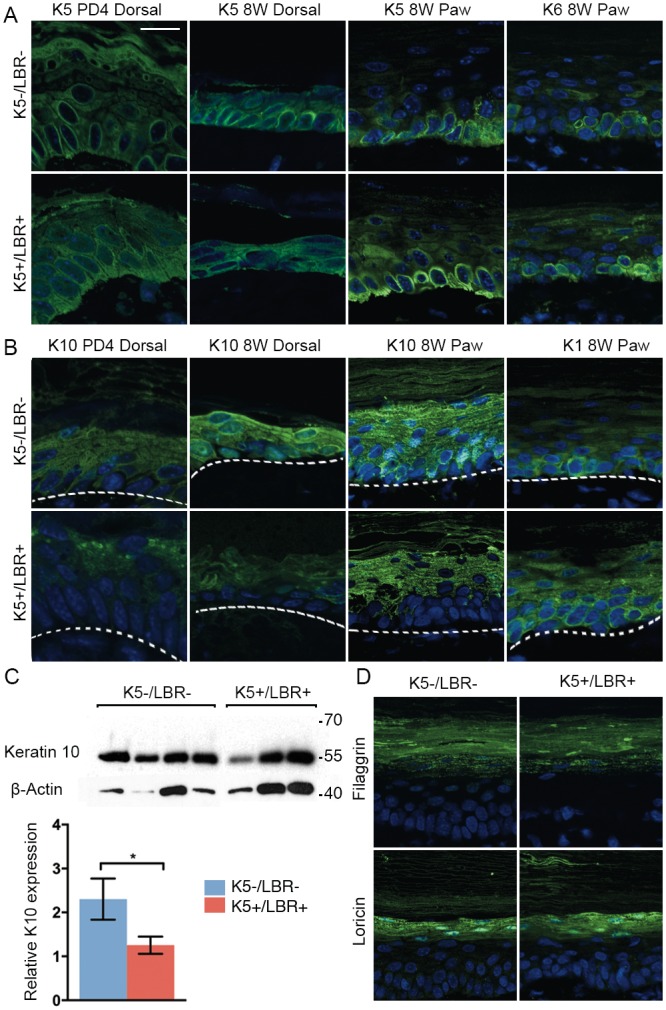
LBR overexpression results in keratin 5 upregulation and keratin 10 downregulation.A-B. Markers for epidermal differentiation (green) and DNA (blue), in dorsal skin from PD4 and week 8, and paw skin from week 8. Keratin 5 (K5) showed positive cells in the basal layer of the interfollicular epidermis; however, in K5+/LBR+ mice, K5 was also upregulated in cells of the suprabasal layer (A). Keratin 1 (K1) was found in the suprabasal layer, mainly in the spinous layer, while keratin 10 (K10) was located mainly in the suprabasal layer. In the K5-/LBR- mice, some cells of the basal layer showed K10, which was not evident in the K5+/LBR+ mice (B). Keratin 6 (K6). The dashed line marks the basal cell layer. C. A representative Western blot including 8-week-old K5-/LBR- (n = 4) and K5+/LBR+ (n = 3) protein extracts from dorsal skin. Keratin 10 protein expression was quantified by Western blot densitometry in K5-/LBR- (blue bars) and K5+/LBR+ (red bars) mice. Numbers and lines indicate molecular weight markers (kDa). D. Loricin and Filagrin (green) expression in the granular layer of paw skin from 8 weeks old mice. Error bars indicate SEM (* p<0.05). Scale bars indicate 20 μm.